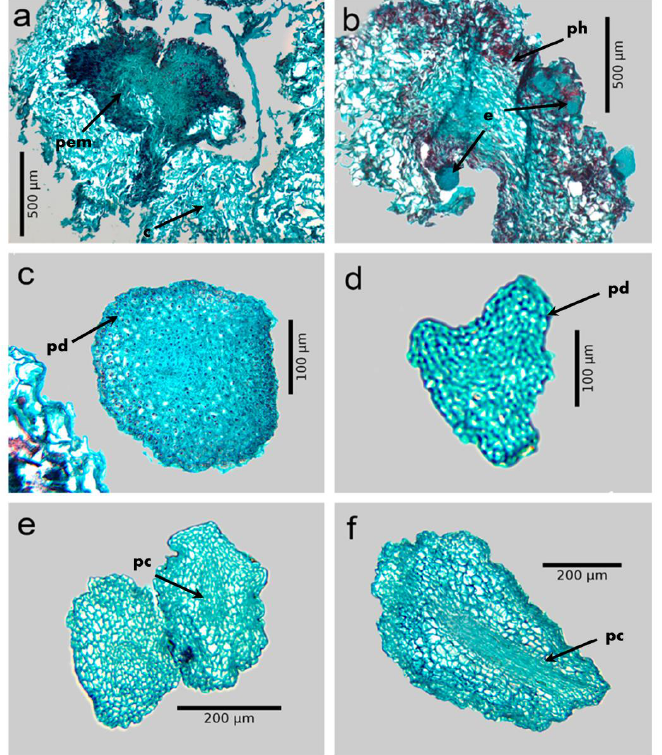
Figure 2. Histology of somatic embryogenesis of Coffea arabica L. var. Colombia. ( a ) Proembryogenic mass forming from a primary callus. ( b ) Somatic embryos differentiated on the proembryogenic mass that produces phenols. ( c ) Globular embryo at 120 d of culture in the differentiation medium. ( d ) Heart stage embryo after 135 d of culture in differentiation medium. ( e ) Early torpedo embryo. ( f ) Torpedo embryo after 150 d of culture on the differentiation medium, showing protodermis and procambium. c: primary callus; pem: proembryogenic mass; ph: phenols; e: embryos; pd: protodermis; pc: procambium.